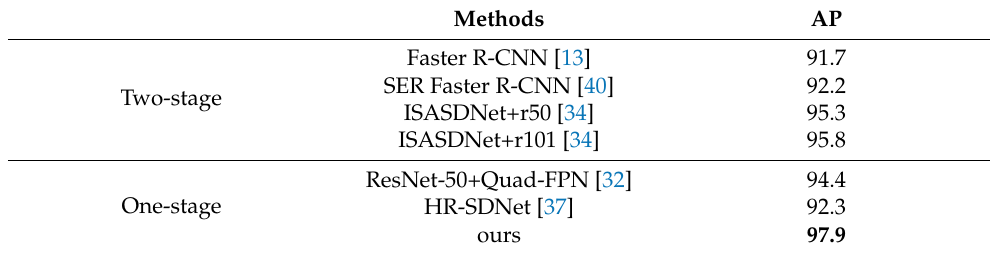
Table 4. Comparison with the latest SAR ship detection methods on SAR-Ship-Dataset.